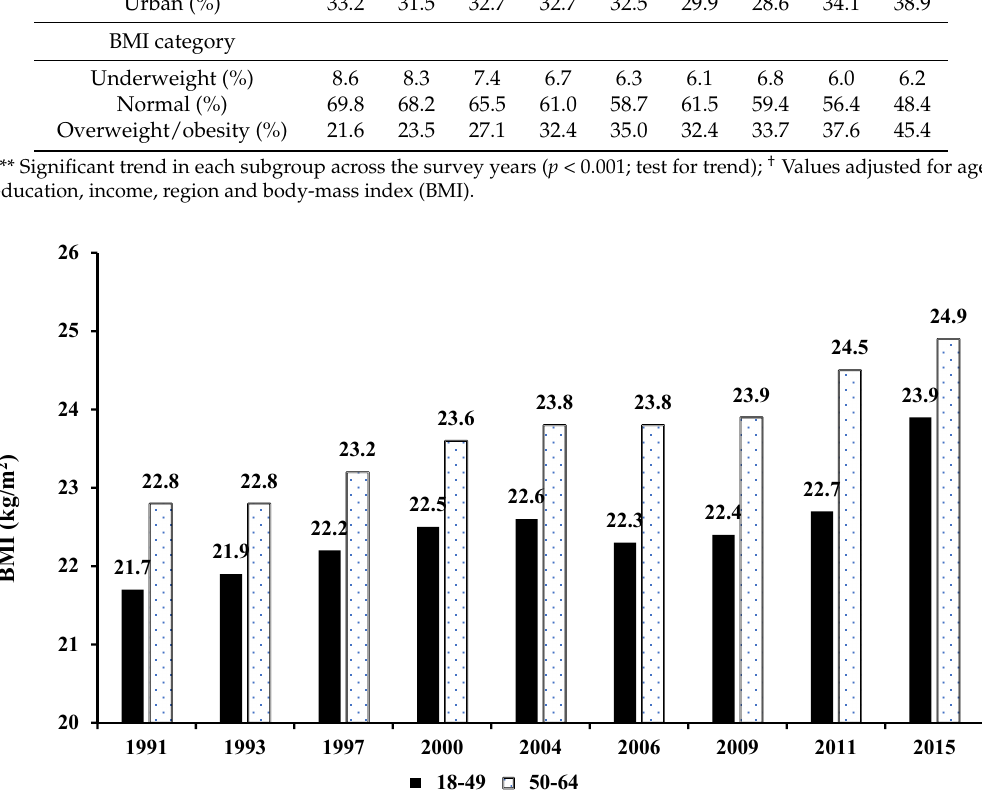
Figure 1. BMI changes in Chinese adult females from 1991 to 2015 by age group (18–49 and 50–64 years).